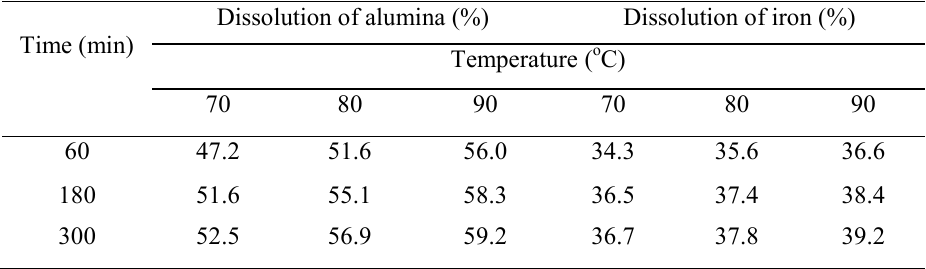
Table 9. Effect of temperature and time on the extraction of alumina and iron with a 2:3 ratio of calcined clay to ammonium sulfate, calcination at 400 o C for 120 min, and leaching with 100 mL of 0.5M sulfuric acid. Dissolution of alumina Time (min)